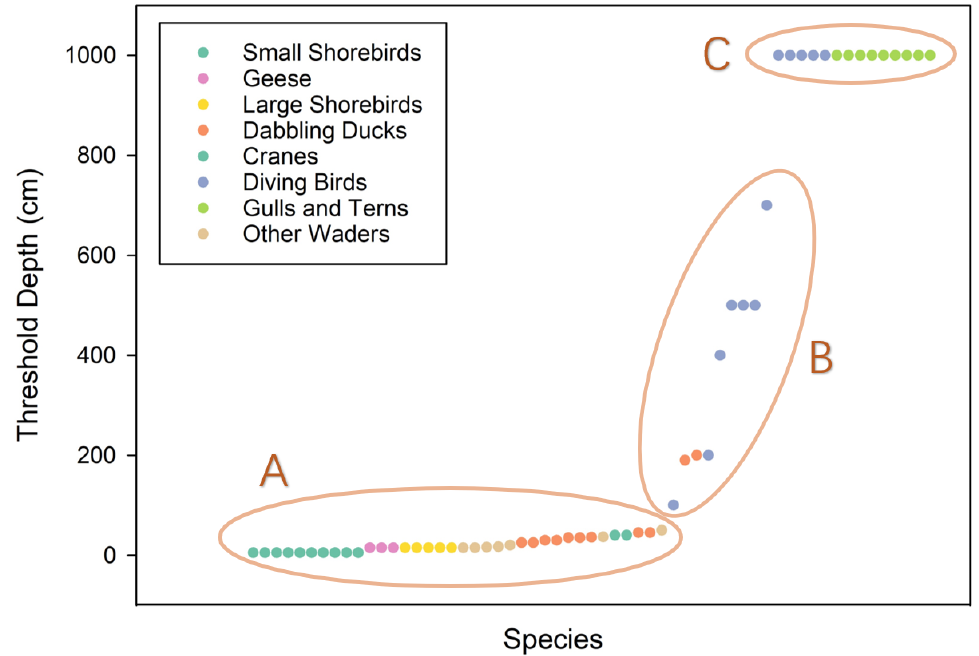
Figure 4. Threshold depths of each species. The threshold naturally distributed to three groups. Water level preference groups were categorized accordingly. A, B, and C sequentially represent the shallow-water preferring group, the moderate-depth-water preferring group, and the deep-water preferring group.